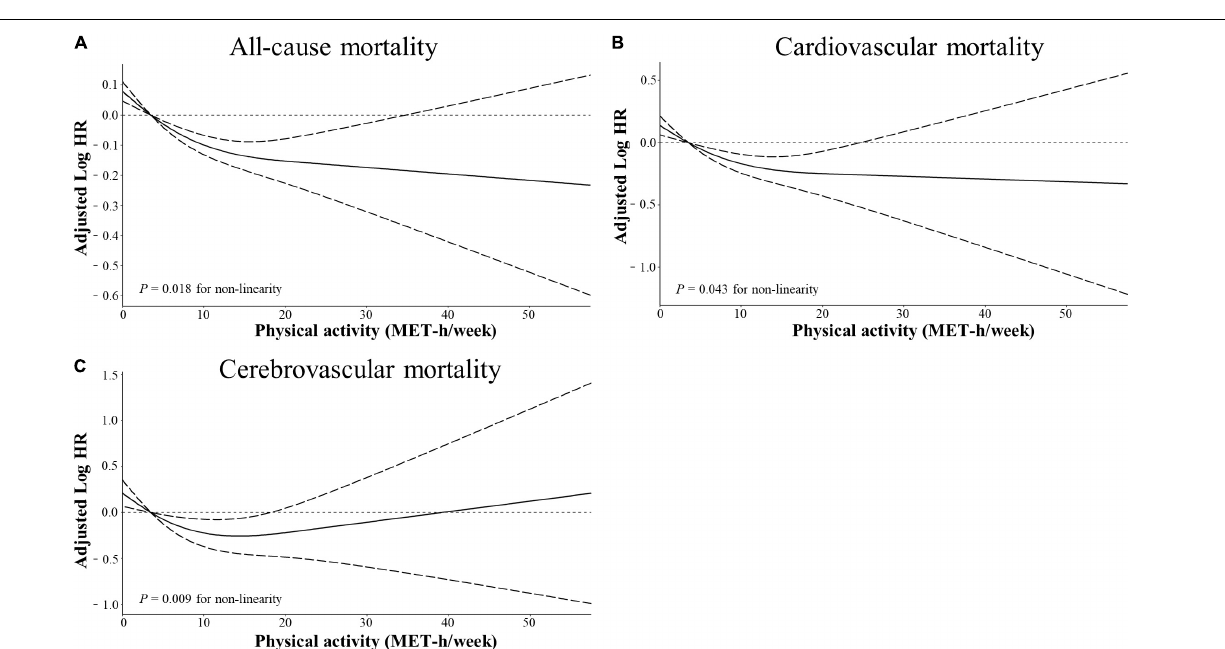
Physical activity, MET-h/week